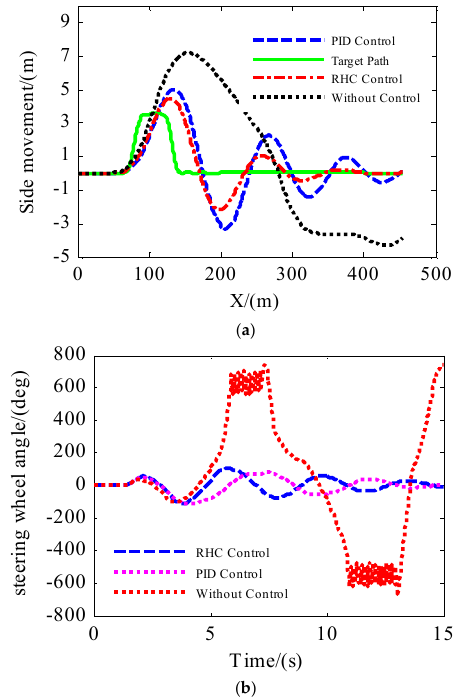
Figure 3. ( a ) Lateral displacement; ( b ) Steering wheel corner.